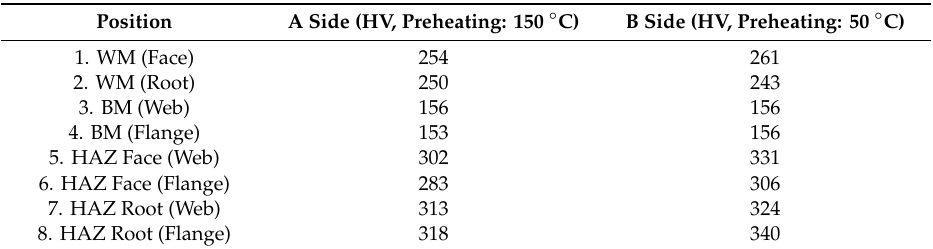
Table 9. Hardness distribution of the double-fillet T-joint welded in FCAW process. WM—weld metal, BM—base metal.